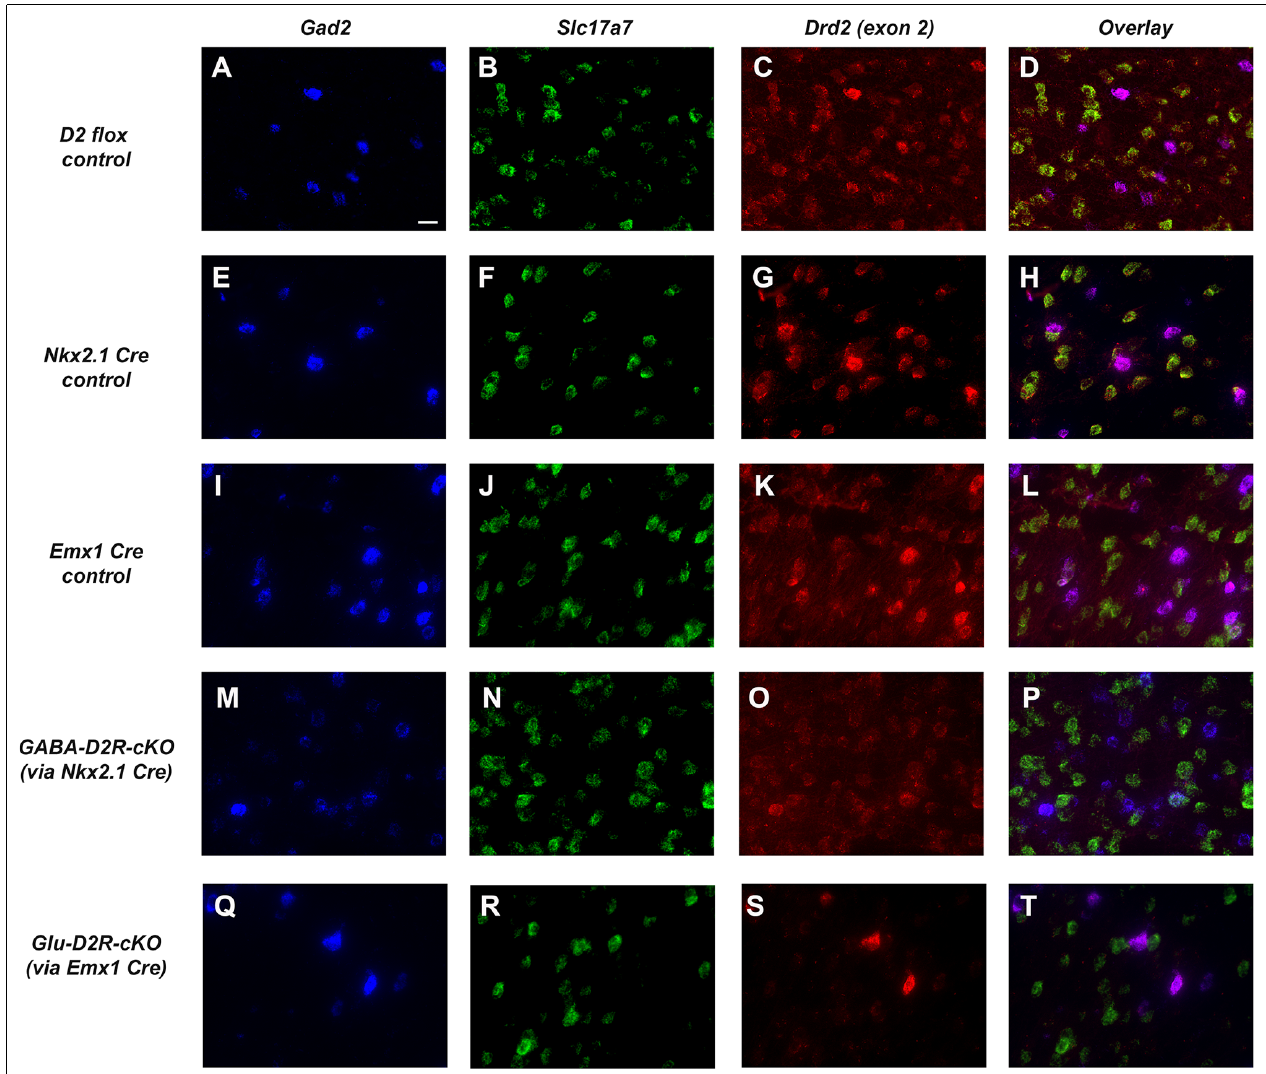
FIGURE 2 | Targeted deletion of D2Rs from ACC GABAergic and glutamatergic neurons in D2R-cKO mouse lines. Representative images using RNAScope (cid:114) -based in situ hybridization for Gad2 (blue, GABAergic neuronal marker; A,E,I,M,Q ), Slc17a7 (green, vesicular glutamate transporter; B,F,J,N,R ), Drd2 (red, C,G,K,O,S ), and corresponding multi-color images (D,H,L,P,T) . Images were collected with a 60 × objective and scale bar = 20 µ m. Drd2 is robustly expressed in both Gad2 -expressing and Slc17a7 -expressing cells in this region of the cerebral cortex (ACC) in control mice (panels A–L ). Note the dramatic reduction in Drd2 expression in Gad2 -expressing cells in GABA-D2R-cKO mice (panels M–P ) but retained expression in Slc17a7 -expressing cells. Conversely, Glu-D2R-cKO mice retain Drd2 expression in Gad2 -expressing neurons (panels Q–T ) but Drd2 is not detectable in Slc17a7 -expressing cells. Images displayed are representative of N =